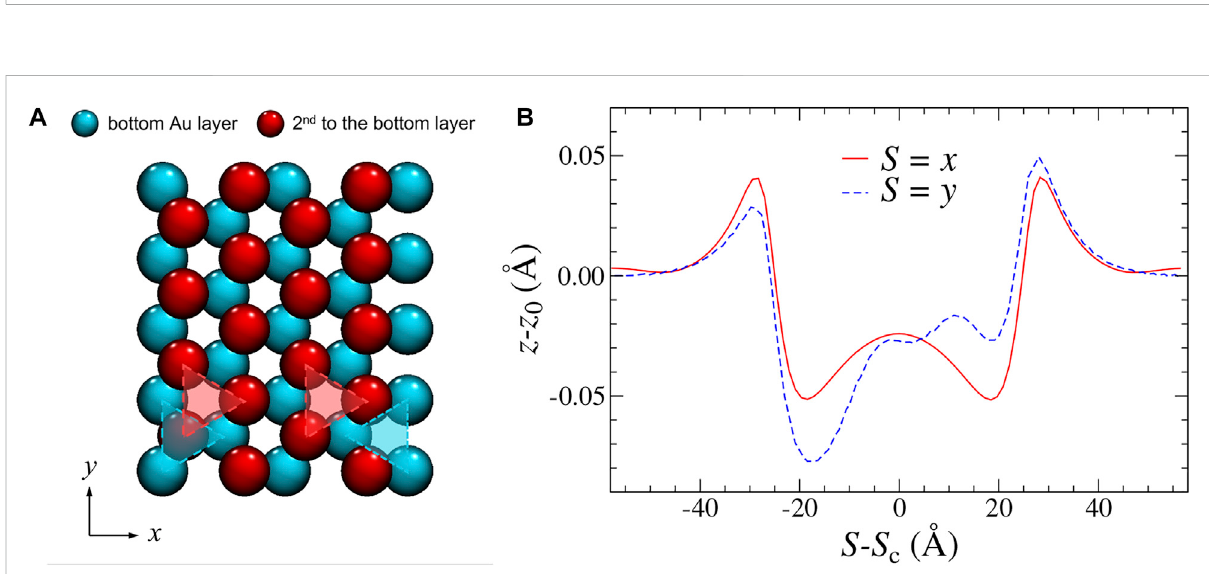
FIGURE 4 (A) Top view of two bottom-most gold layers. Cyan atoms are in direct contact with the graphite layer, while red atoms are one layer further up. (B) Spatially resolved normal displacement of the topmost graphite layer along the fi nite direction of an x -stripe (solid, red line) and a y -stripe (dashed, blue line). Note that in-plane and out-of-plane directions are not true to